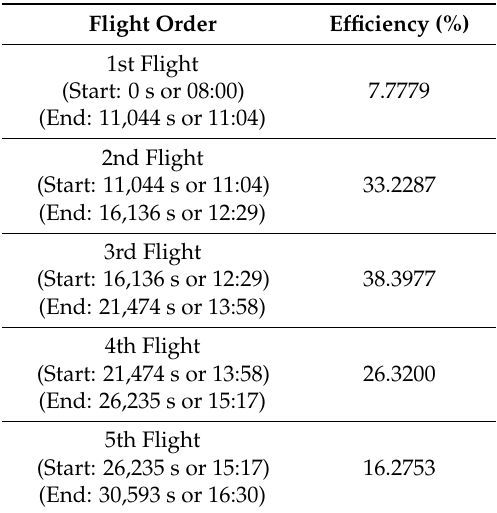
Table 8. Charging vs. discharging time